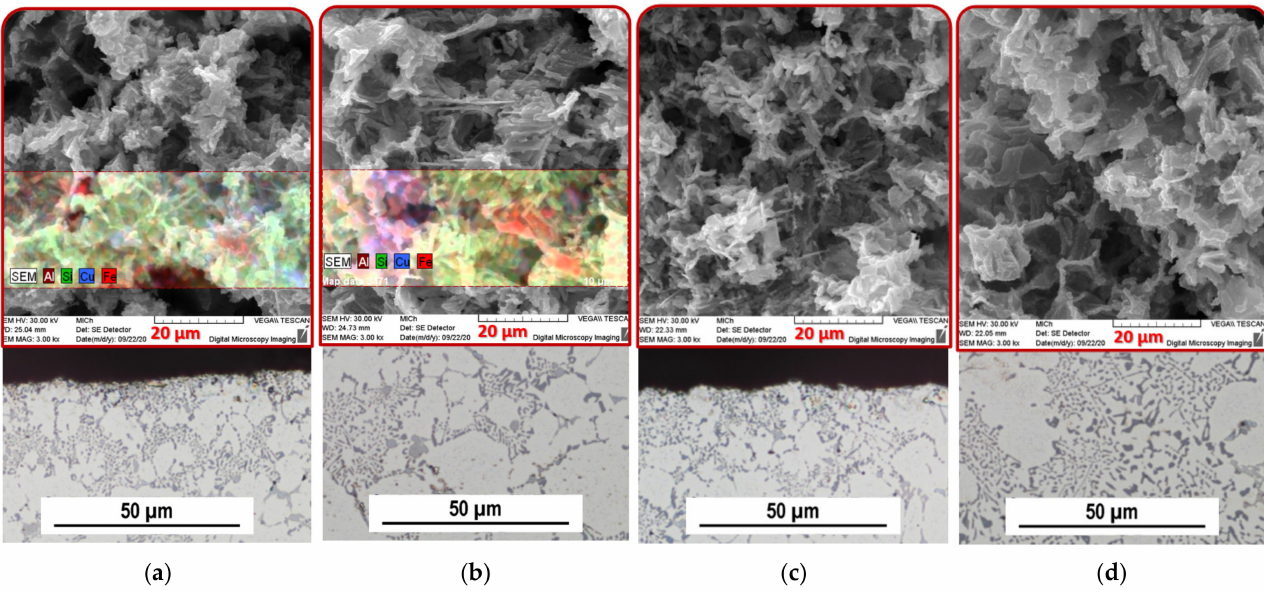
Figure 8. Images of the structure of the castings from the Z10 and Z55 alloys after heat treatment; OM, SEM: ( a ) Z10 surface; ( b ) Z10 central region; ( c ) Z55 surface; ( d ) Z55 central